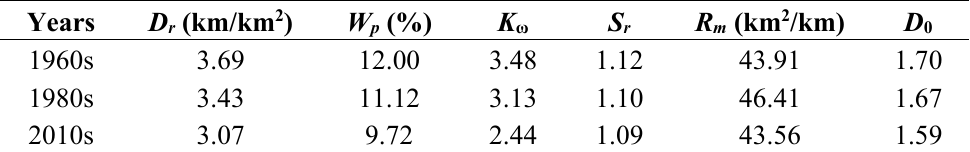
Table 2. Changes of river indicators in the Taihu Region during the 1960s to 2010s.